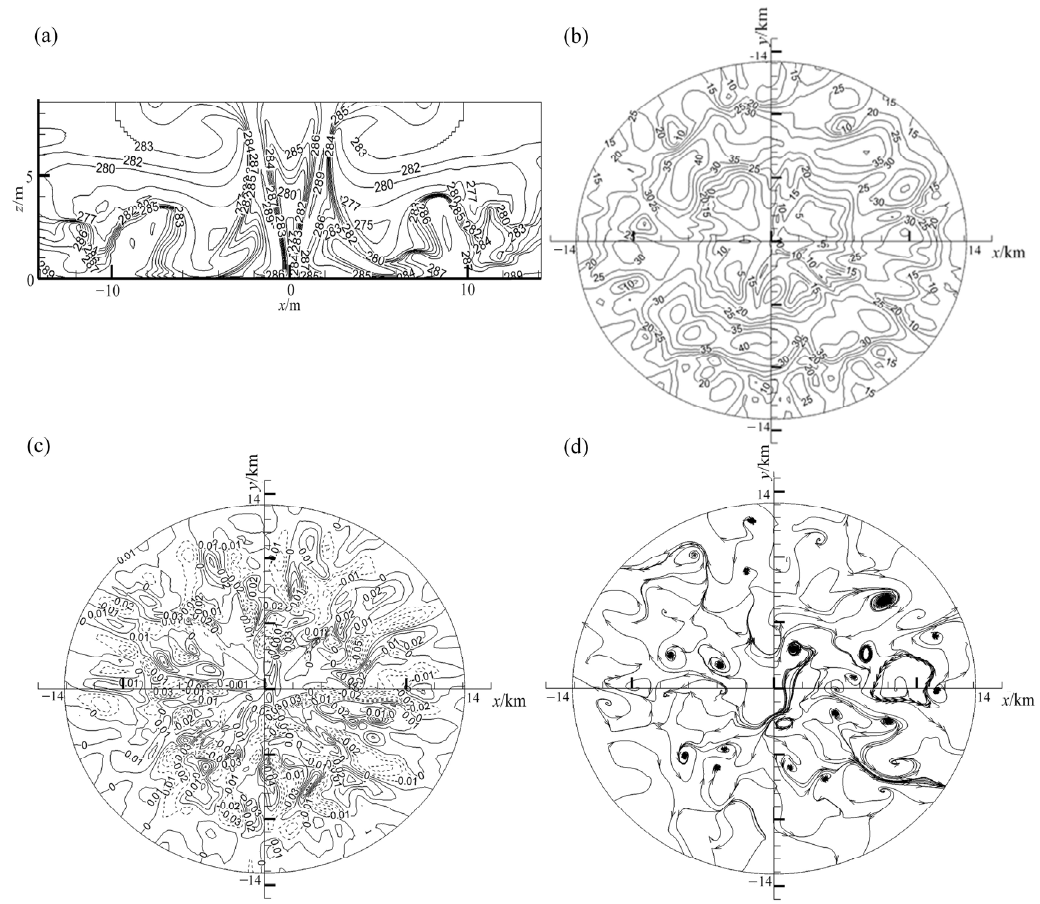
Figure 7. The air flows field at t = 1000 s under the action of a cold pool with a diameter of 2000 m. ( a ) Air temperature in the central vertical plane z–x; ( b ) horizontal velocity contours in the x–y plane, z = 1000 m; ( c ) vorticity contours in the x–y plane, z = 1000 m and ( d ) streamlines in the x–y plane, z = 1500 m.